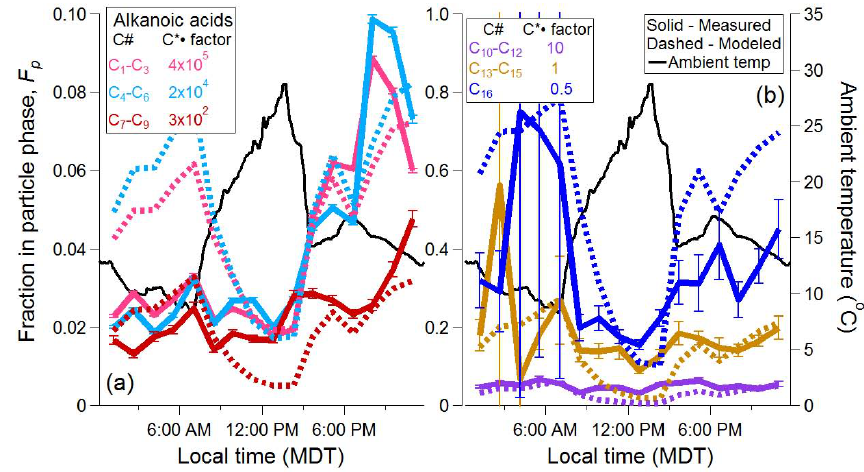
Fig. 12. Time series of measured (solid) and modeled (dashed) F p for alkanoic acids on 26 August 2011 averaged into different carbon number bins. Multiplicative factors used to increase or decrease the C ∗ for model results to allow comparison of relative trends with the data are also shown in the legend. Note the change in y -axis scale for the left and right panels.